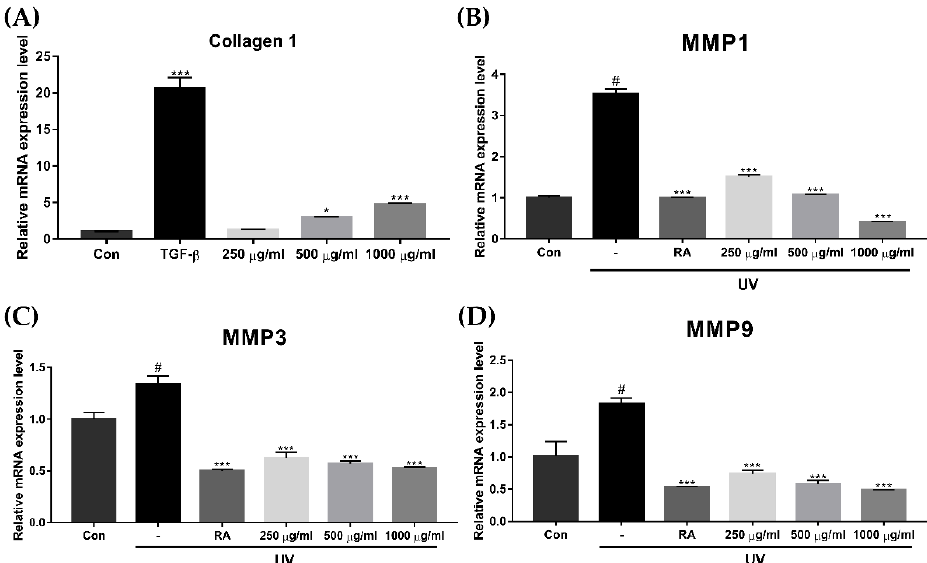
Figure 4. Relative messenger RNA expression levels of Collagen 1 , MMP1 , MMP3 , and MMP9 in the HDF cells. The collagen 1 gene expression level was increased concentration dependently in the EverCTP TM (NEWTREE Co., Ltd., Seoul, Korea) treatment group compared to the CON group ( A ). MMP1 ( B ), MMP3 ( C ), and MMP9 ( D ) gene expressions were induced by 10 mJ/cm 2 of UVB irradiation, and induced MMP family gene expressions were decreased with EverCTP TM treatment; # p < 0.005, independent samples t -test compared with the CON group; * p < 0.05, *** p < 0.005, independent samples t -test compared with the CON group ( A ) or the UV irradiation group ( B – D ). TGF- β , transforming growth factor-beta; RA, retinoic acid; MMP, matrix metalloproteinase; HDF, human dermal fibroblast; CON, control; UVB, ultraviolet-B; UV, ultraviolet.